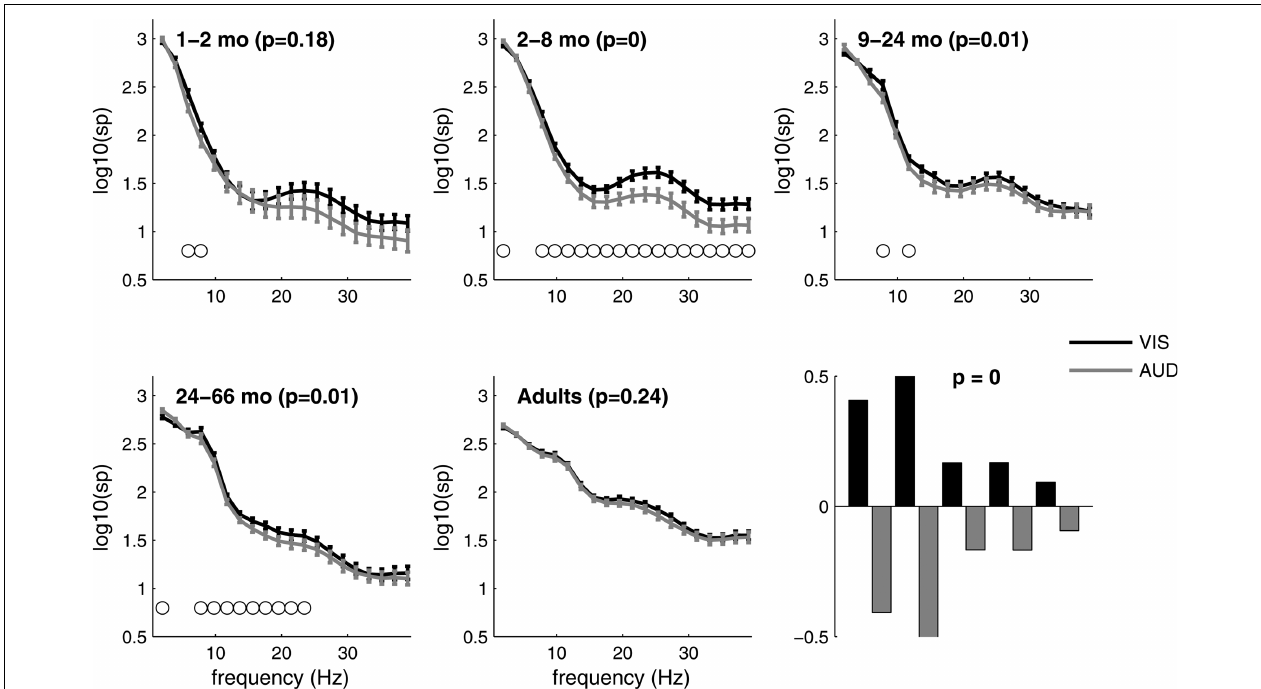
FIGURE 5 | Spectral power distribution in VIS vs. AUD conditions across fi ve age groups. Group mean log power in VIS and AUD conditions is displayed, together with group standard errors. The outcome of signifi cance testing for differences in spectral power distribution between two conditions within each group are given as p-values. The circles above the frequencies indicate portions of the spectral power curve that differ between conditions based on a 99% confi dence interval derived from bootstrap estimation. The